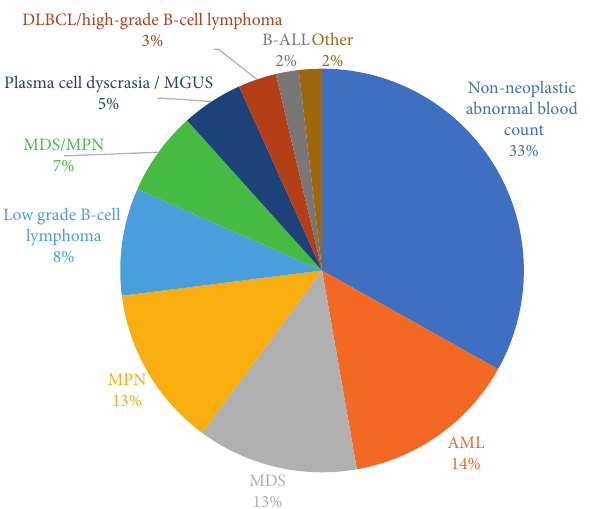
Figure 2: Distribution of diagnoses in the study population. MDS, myelodysplastic syndrome; AML, acute myeloid leukemia; MPN, myeloproliferative neoplasm; MGUS, monoclonal gammopathy of uncertain significance; DLBCL, diffuse large B-cell lymphoma; BALL, B-acute lymphoblastic